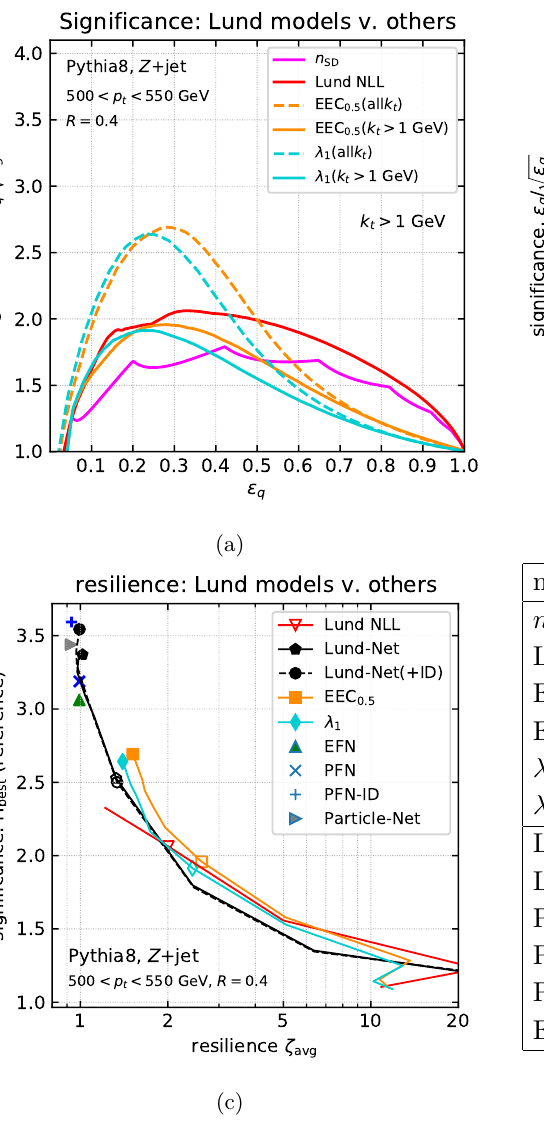
Figure 9. Comparison of the Lund-plane-based approaches with other models. Explicit plots of √ the signal significance ε ε g are shown in the upper plots, first for analytic discriminants, figure q / (a), then for machine-learning-based approaches, figure (b). The bottom panel, figure (c), shows the corresponding performance v. resilience plot, where the resilience is measured with respect to the choice of Monte Carlo generator (cf. section 7.3). The table on the bottom-right corner gives the area under the ROC curve (AUC) for the different models (lower is batter). For the ML-based models, the uncertainty is half the difference between the minimal and maximal values obtained over 5 different